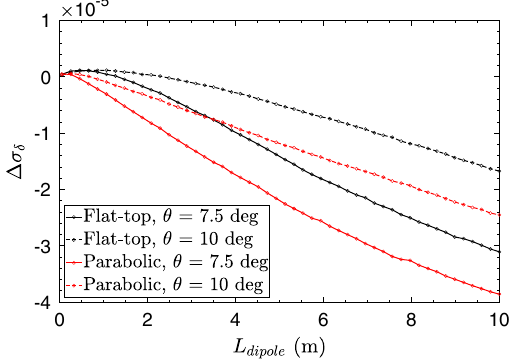
FIG. 13. Distorted phase space resulting from the CSR effect estimated using Eqs. (7), (8).